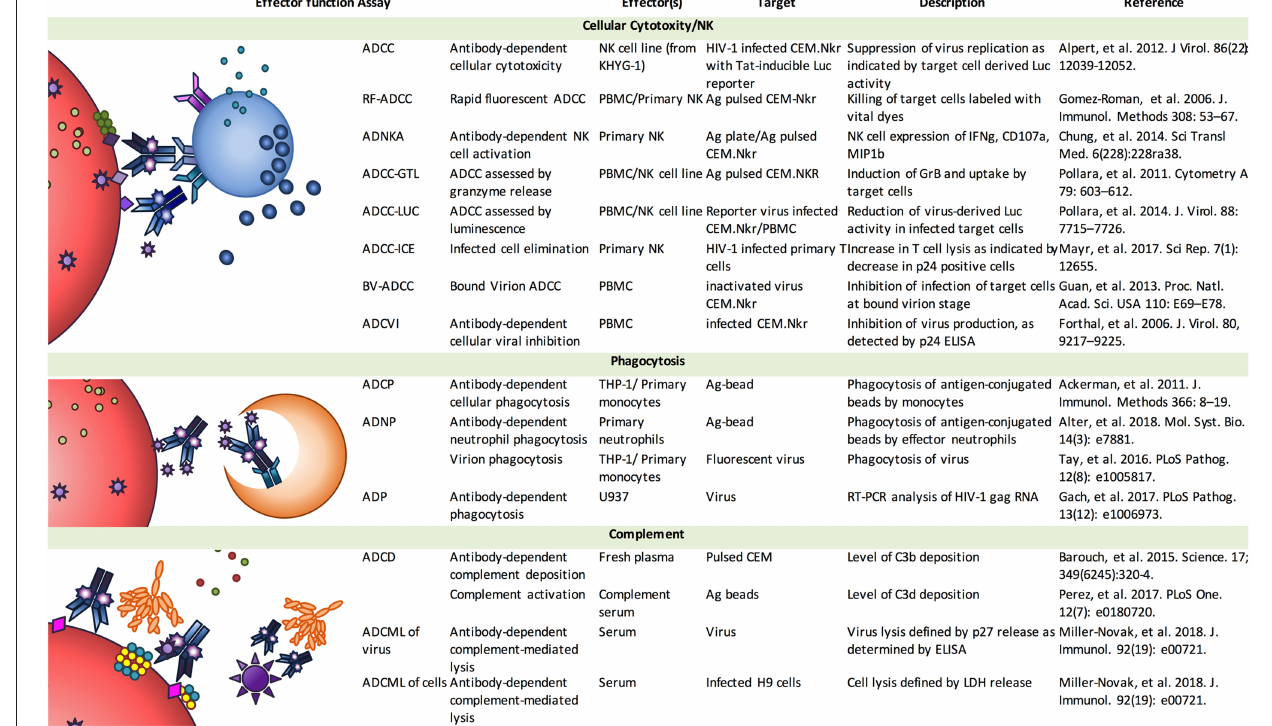
cytokines from effector cells, rich insights into these aspects of immunobiology result from analysis of various monoclonal and polyclonal antibody samples across